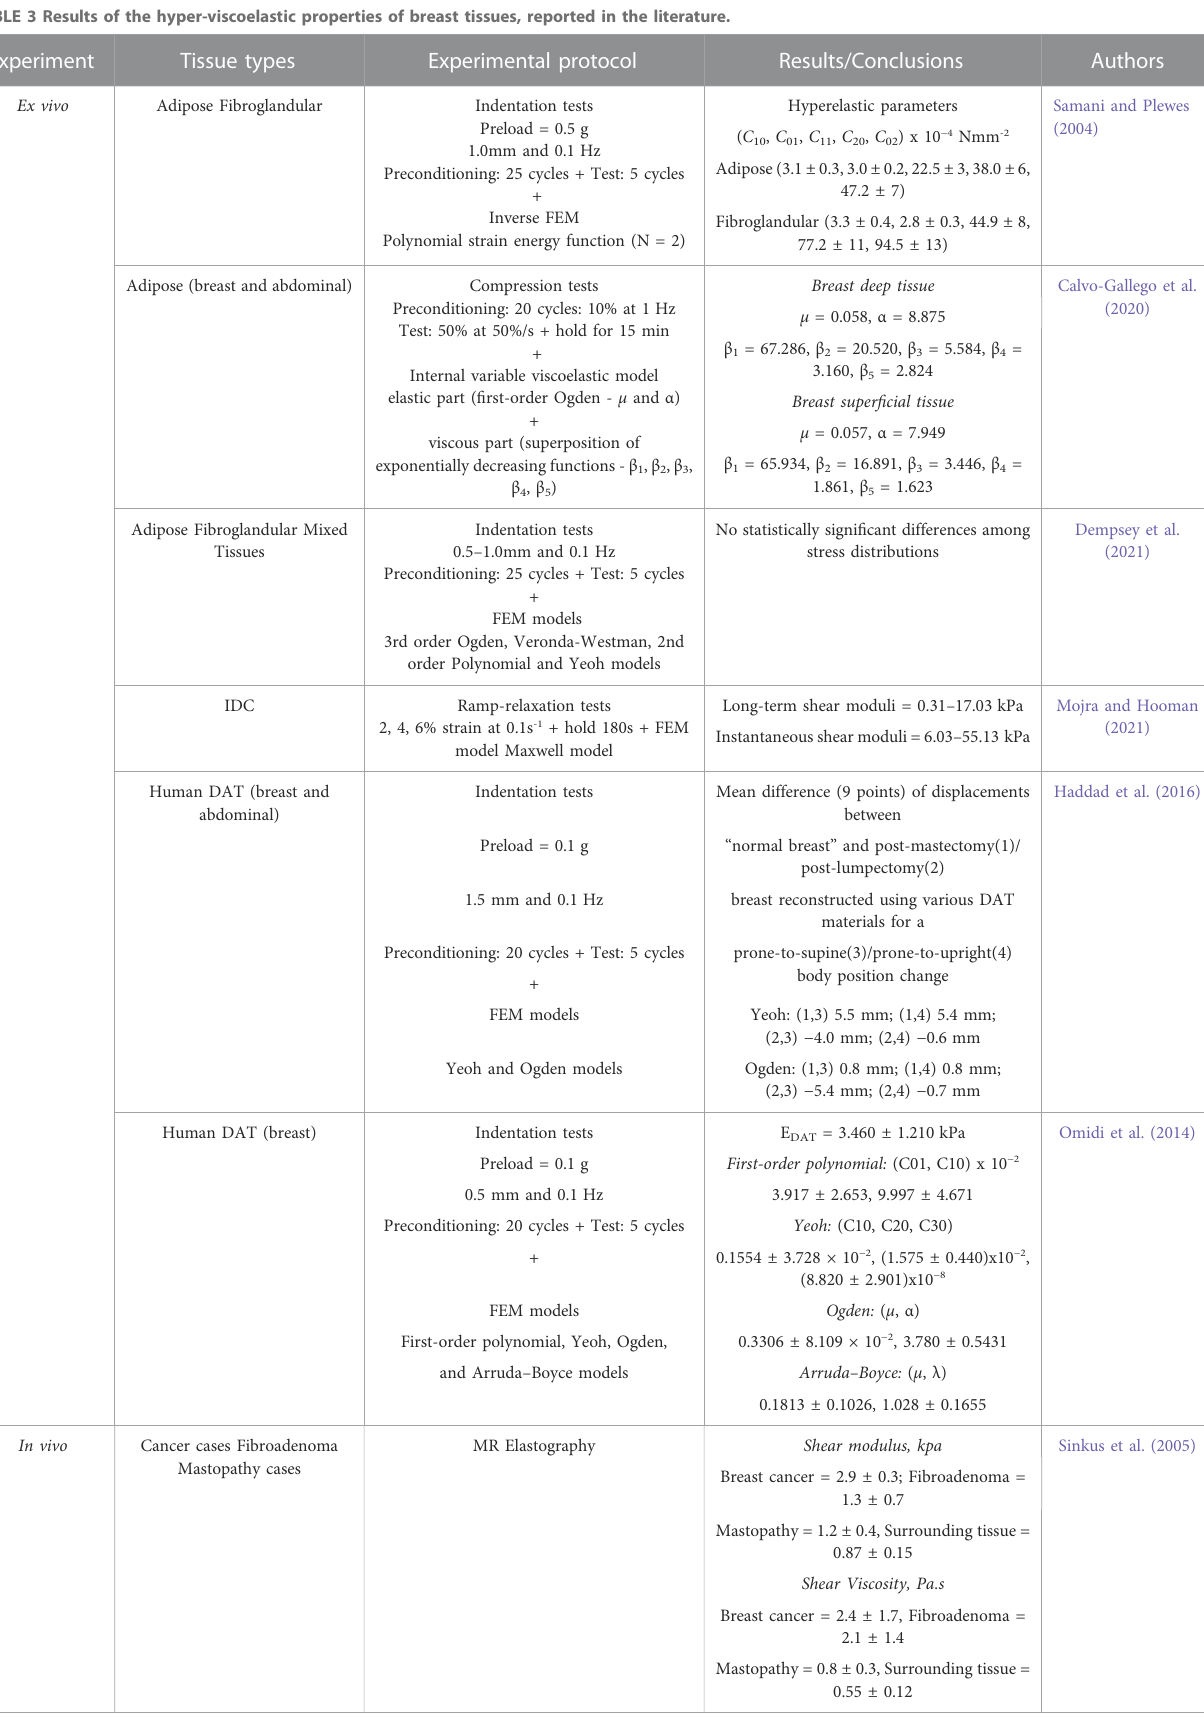
TABLE 3 Results of the hyper-viscoelastic properties of breast tissues, reported in the